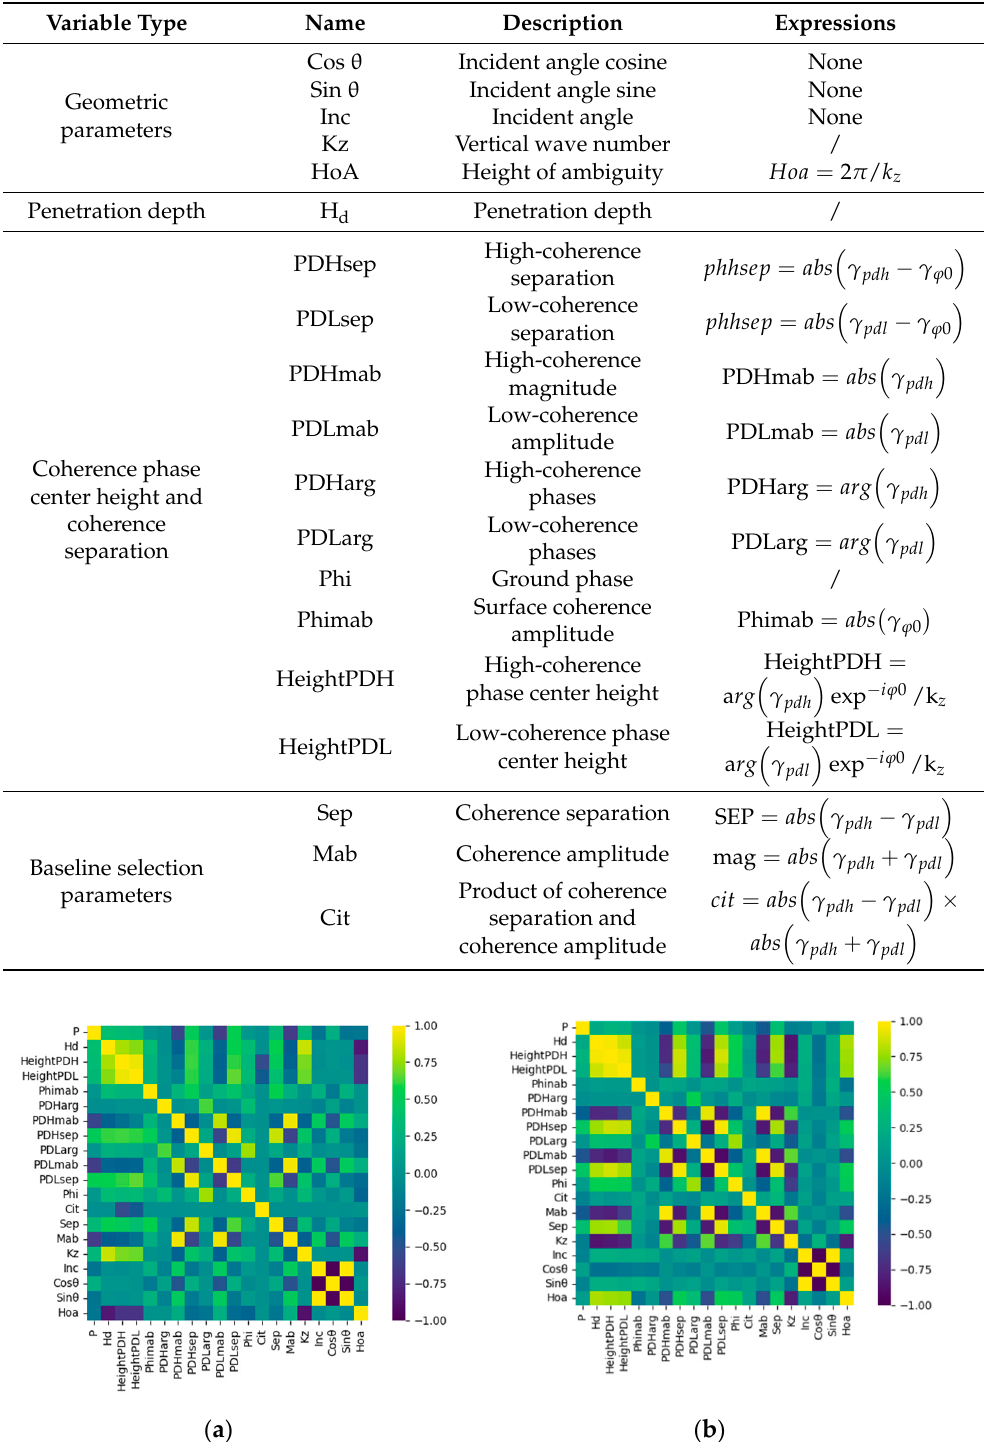
Table 5. List of independent variables used in machine learning methods.